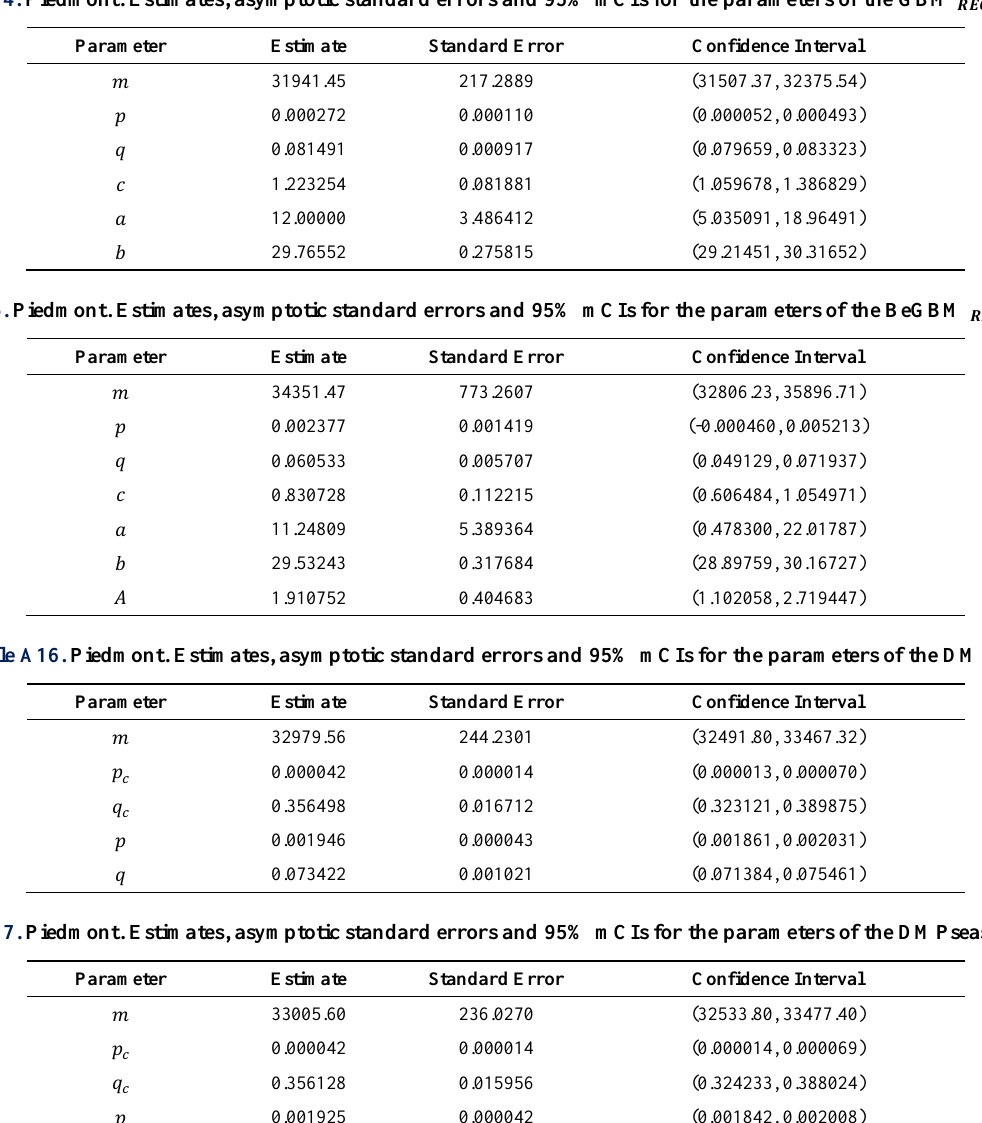
Table A14. Piedmont. Estimates, asymptotic standard errors and 95% mCIs for the parameters of the GBM 𝑹𝑬𝑪𝑻 (4)+(5).